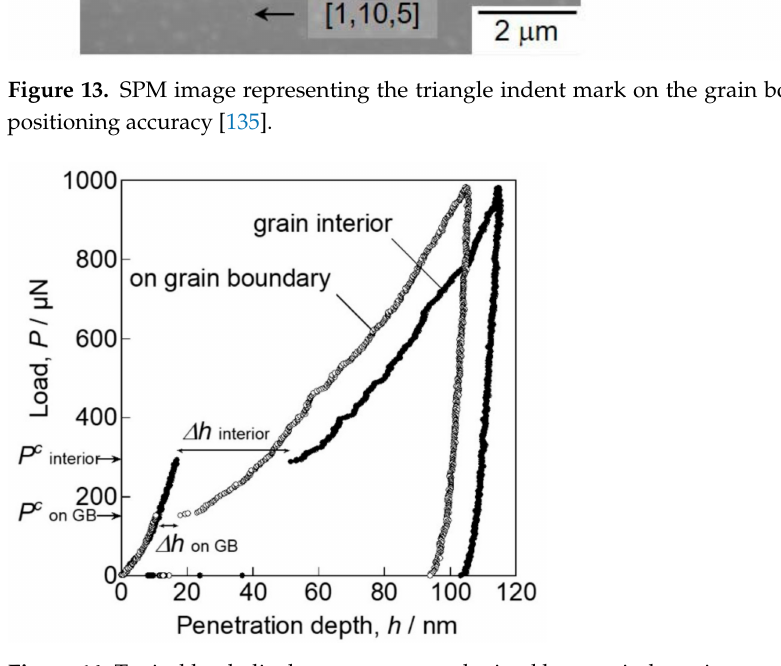
Figure 14. Typical load–displacement curves obtained by nanoindentation measurements just above the grain boundary and within the grain interior far from the grain boundary [135].